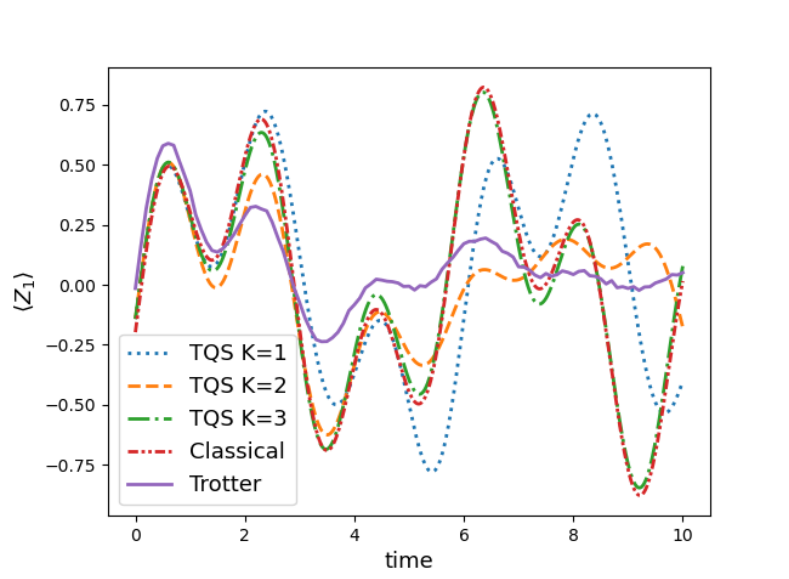
Figure 5: Dynamics of H compared between Trotterization and TQS. The noise 2, TFI model was taken from the IBM Quantum Experience provider, mimicking the noise of the real quantum processor ibmq_bogota . We used a total of 100 steps for the 〉 is shown. Trotterized run. The expectation value of 〈 Z 1